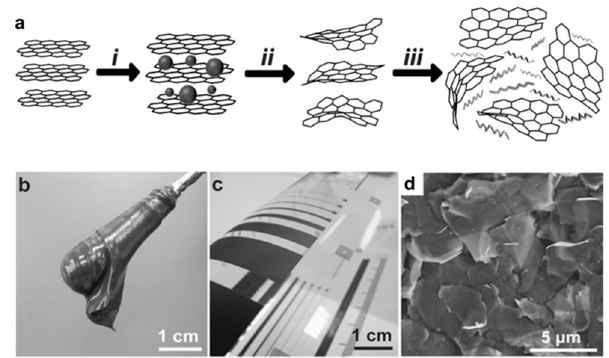
Figure 4. ( a ) Schematic illustration of the (i) graphite intercalation, (ii) thermal expansion, and (iii) graphene gelation; ( b ) image of graphene paste on a spatula; ( c ) poly(ethylene terephthalate) (PET) foil with a test pattern screen printed with graphene paste, ( d ) SEM images of large-area prints at 5000× magnification. Reproduced with permission from Reference [83]. Copyright © 2016 Wiley.